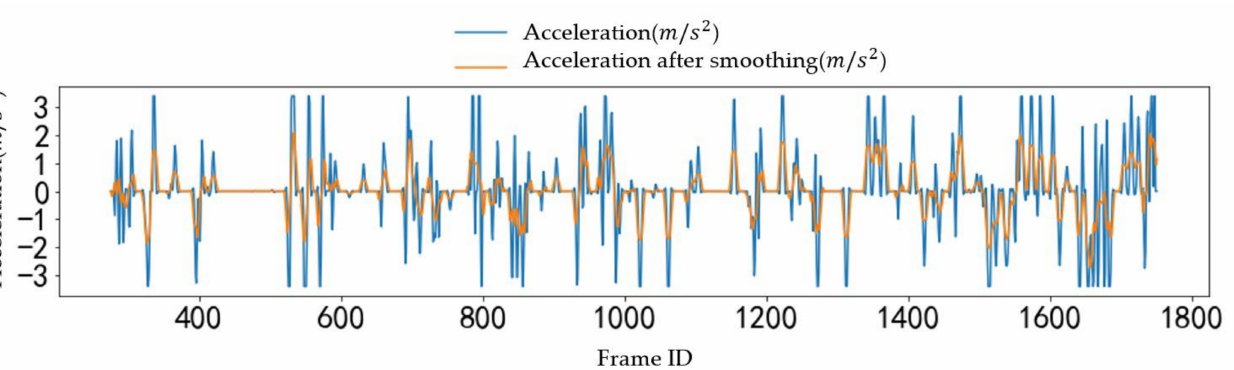
Figure 4. Diagram of vehicle trajectory data smoothing (acceleration as an